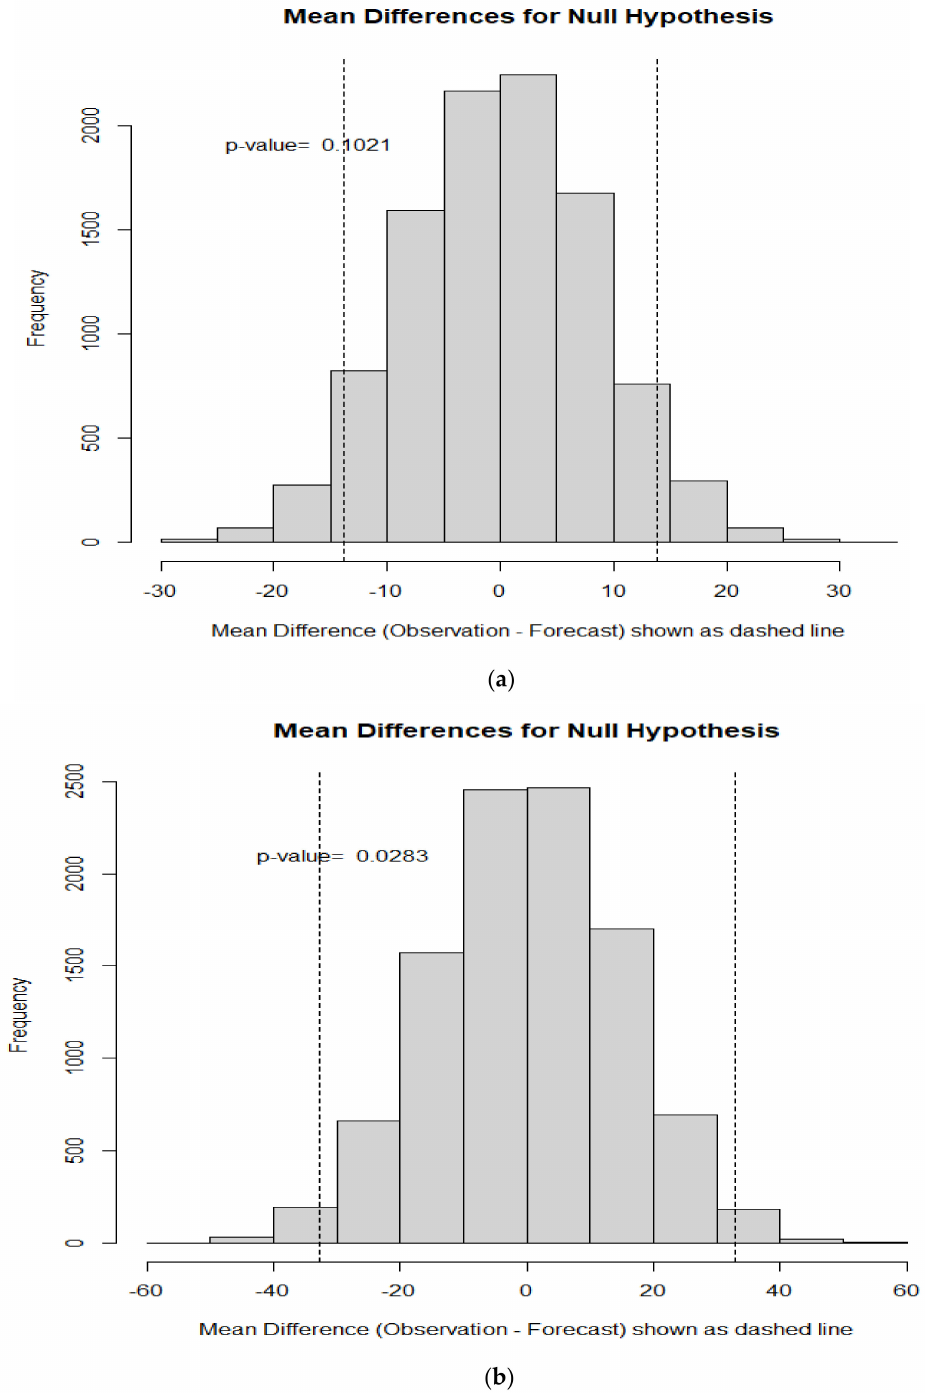
Figure 15. ( a , b ). Histograms of the mean differences between observed EC and model forecast EC for the Regression ( a ) and WARMF ( b ) models for model forecast lead time ∆ Day +